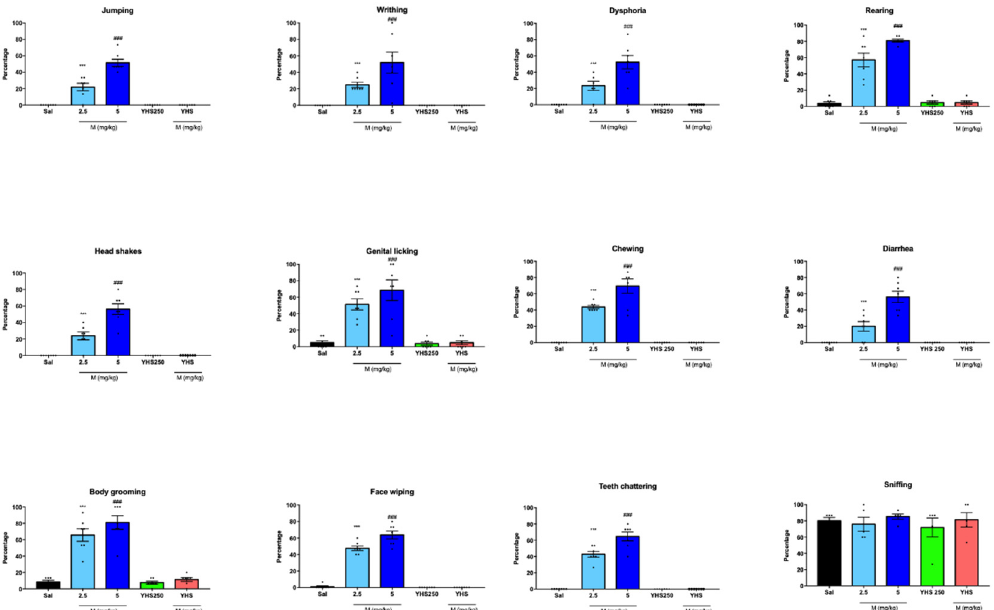
Figure 3. YHS inhibits morphine physical dependence after i.p. administration. Jumping, writhing, head shakes, genital licking, body grooming, face wiping, teeth chattering, dysphoria, rearing, chewing, diarrhea, and sniffing after naloxone injection (n = 8). One-way ANOVA revealed significant percentage of jumping, writhing, head shakes, genital licking, body grooming, face wiping, teeth chattering, dysphoria, rearing, chewing, and diarrhea in both morphine groups, F = 65.51 p < 0.0001, followed by Tukey’s multiple comparison test M2.5 *** p < 0.0001 compared with saline, M5, YHS 250, and M2.5YHS250; M5 ### p < 0.0001 compared with saline, M2.5, YHS 250, and M2.5 YHS250. YHS inhibits the rewarding properties of morphine.